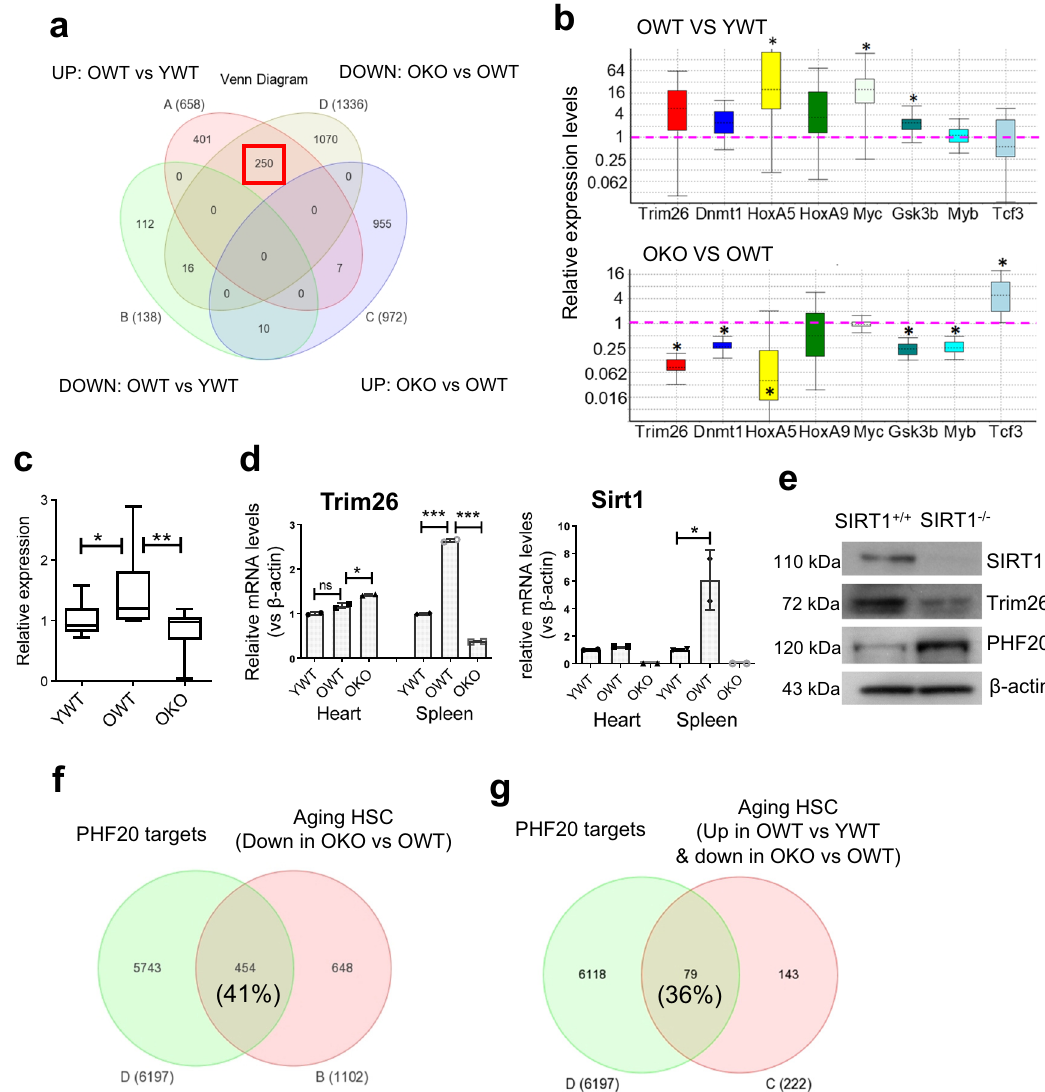
Fig. 8 SIRT1 knockout impacted multiple downstream effectors in aging HSCs. a Venn diagram analysis identi fi ed 250 genes that were up in OWT compared to YWT, but were down-regulated in OKO HSC cells. b Realtime RT-PCR validation of key genes identi fi ed in a . Geometric averaging of multiple control genes ( β -actin, 18S RNA and CD45) was used to normalize data. c Trim26 mRNA in puri fi ed HSCs in independent aging cohorts ( n = 7 each). d Trim26 and Sirt1 mRNA in spleen and heart using unfractionated cells. e Western blot analysis of MEF cell lysates. f , g Overlap of PHF20 target genes with genes down in OKO over OWT HSCs ( f ) and 222 annotated genes from 250 genes that were up in OWT vs YWT but down in OKO ( g ). * P < 0.05; ** P < 0.01; *** P < 0.001. n.s. not signi fi cant. Error bars represented one standard